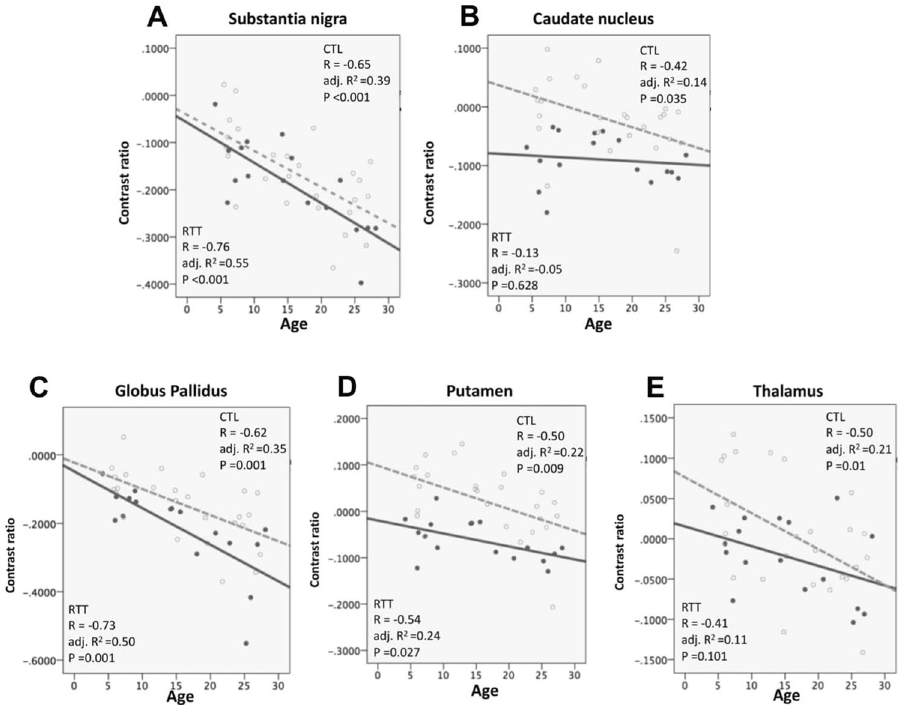
Figure 2. Scatter plots of the estimated age-related regression between age and contrast ratio. Regression model indicated the contrast ratio decreased significantly with age in both RTT and control groups. However, the contrast ratios were lower in RTT. The green cross/bold line was the data for RTT, and the blue square/dash line was the data for the